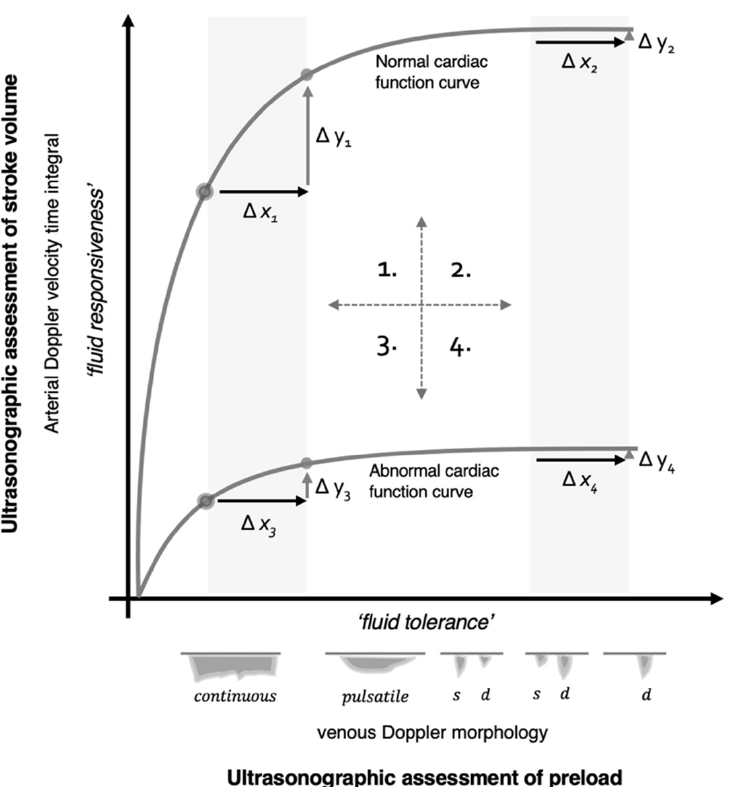
Figure 3. Physiological Framework linking fluid ‘tolerance’ and ‘responsiveness’. See text for details. The graph is split into quadrants highlighting 4 physiological states where changing preload ( ∆ x , fluid tolerance) compares with changing stroke volume ( ∆ y , fluid responsiveness ). Doppler surrogates for preload may be right-heart based (e.g., systemic vein Doppler velocimetry, VExUS) or left-heart based (e.g., pulmonary vein Doppler velocimetry, E/e’ ratio, etc.).